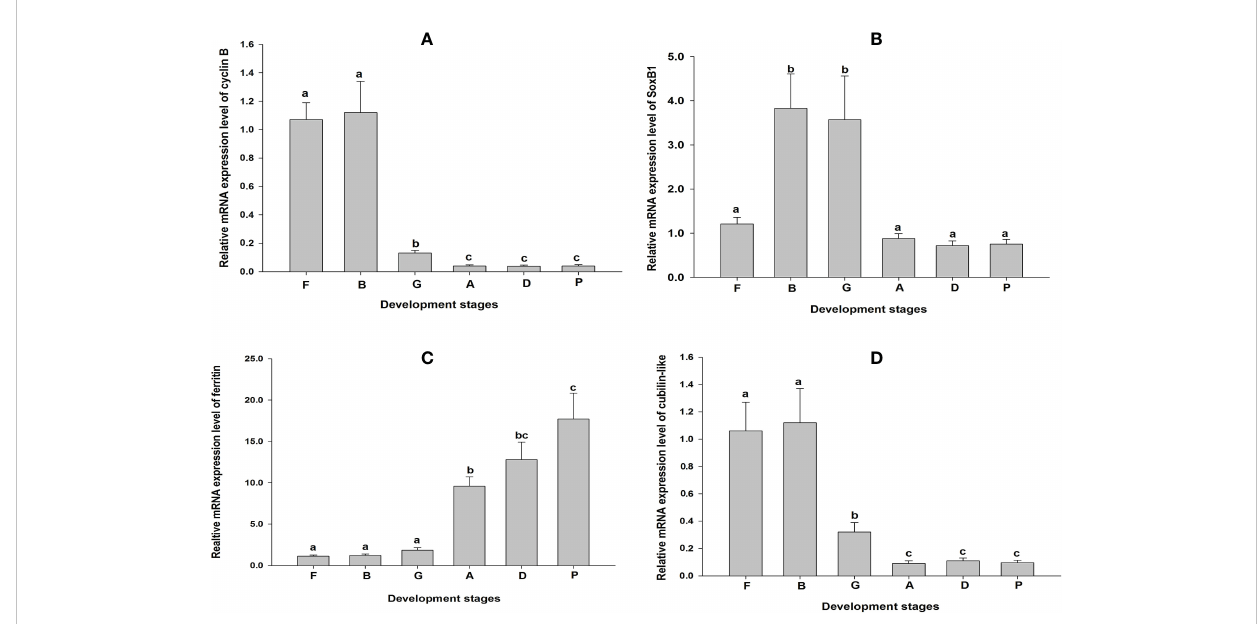
FIGURE 5 Validation of cyclin B (A) , SoxB1 (B) , ferritin (C) and cubilin-like (D) using RT-PCR. Data are shown as the mean ± SD. The lowercase letters indicate statistically signi fi cant differences ( p <